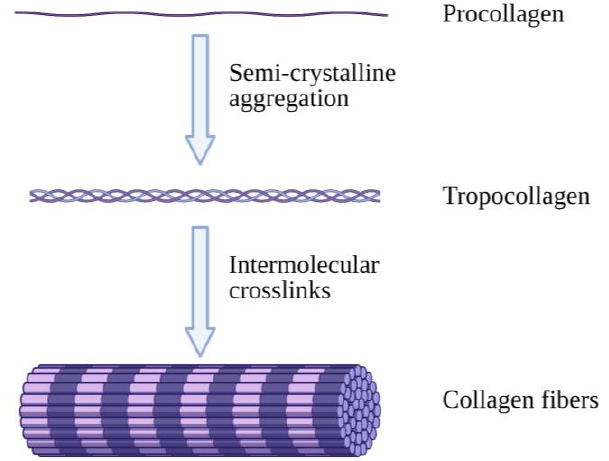
Figure 1. Illustrative image of collagen fibre formation. Collagen molecules intertwine with each other, forming collagen fibrils, which are then combined and form collagen fibres. Created with Biorender.com (Accessed date: 10 February 2021).